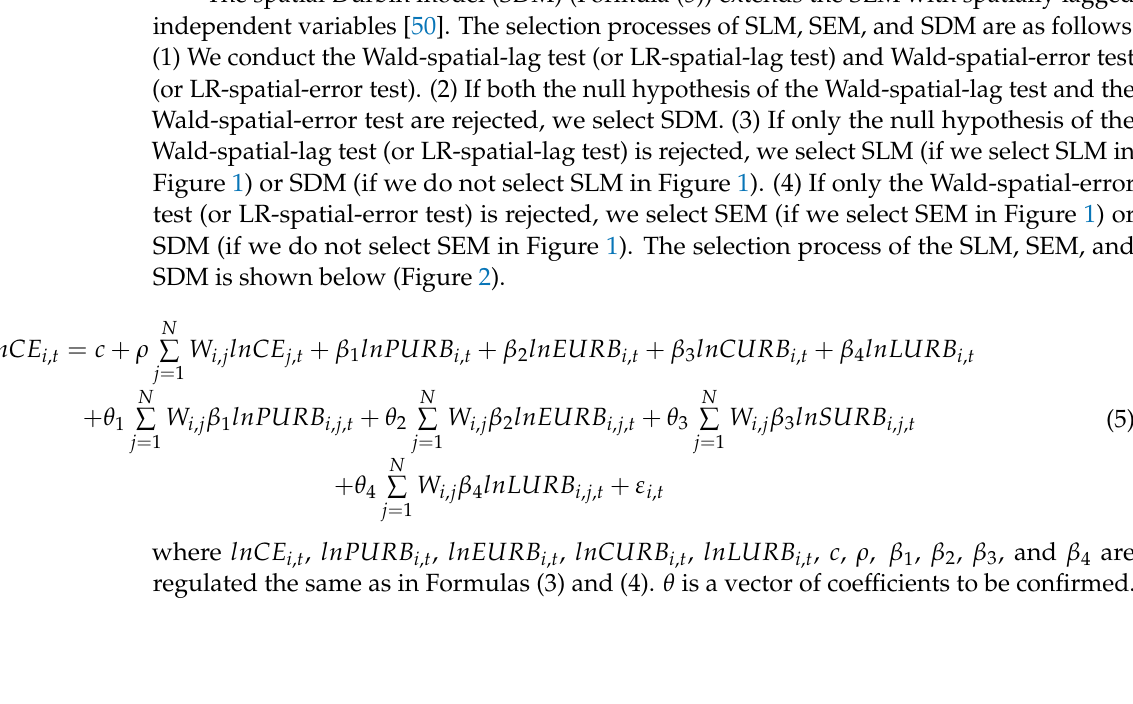
Figure 1. The selection of the SLM and SEM.